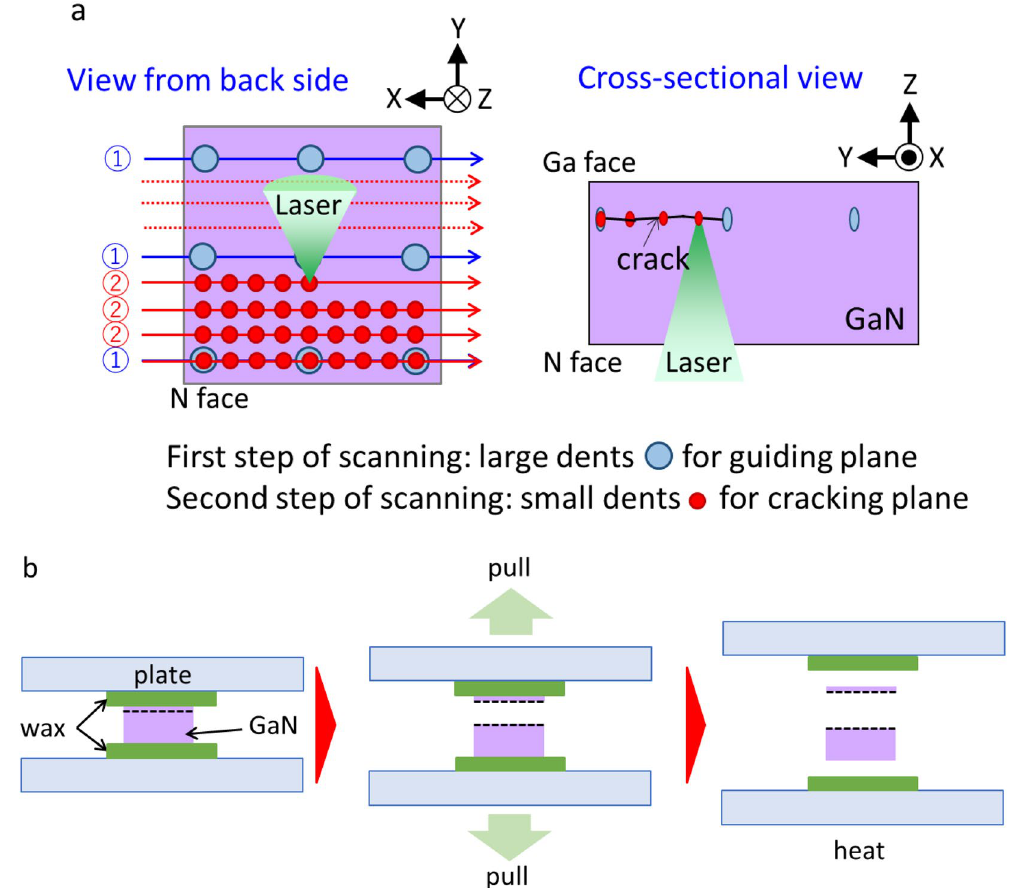
Figure 1. Schematic images of laser slicing. ( a ) Laser irradiation. ( b ) Separation.